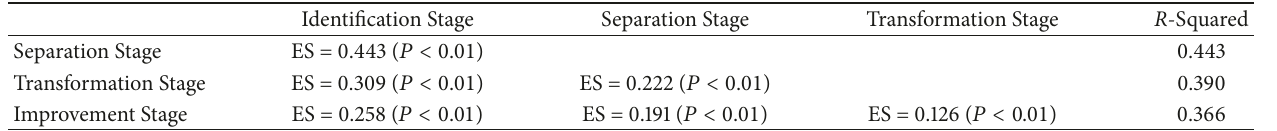
Table 5: Effect sizes of direct effects.